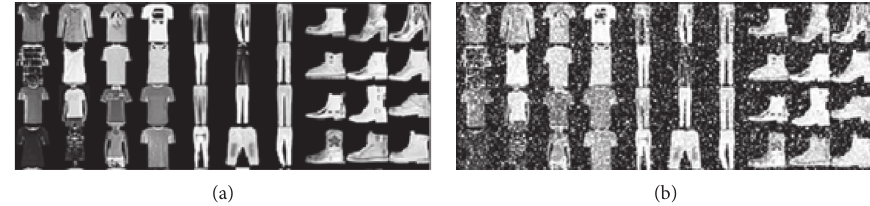
Figure 21: Examples of original “T-shirt,” “pants,” “boots,” and examples with added noise.